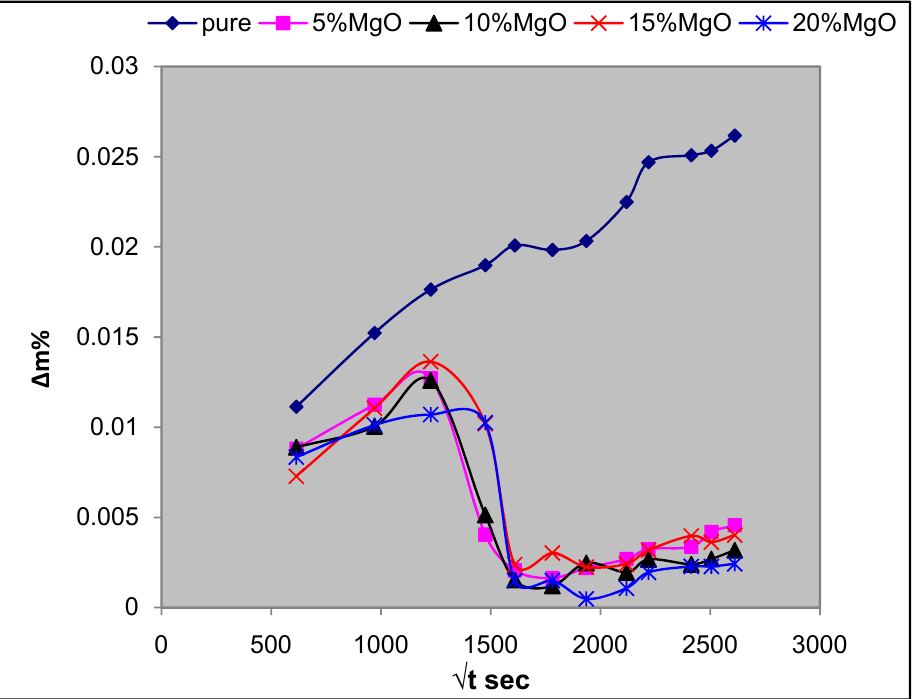
Fig. 1: The change in weight with the immersion time in H